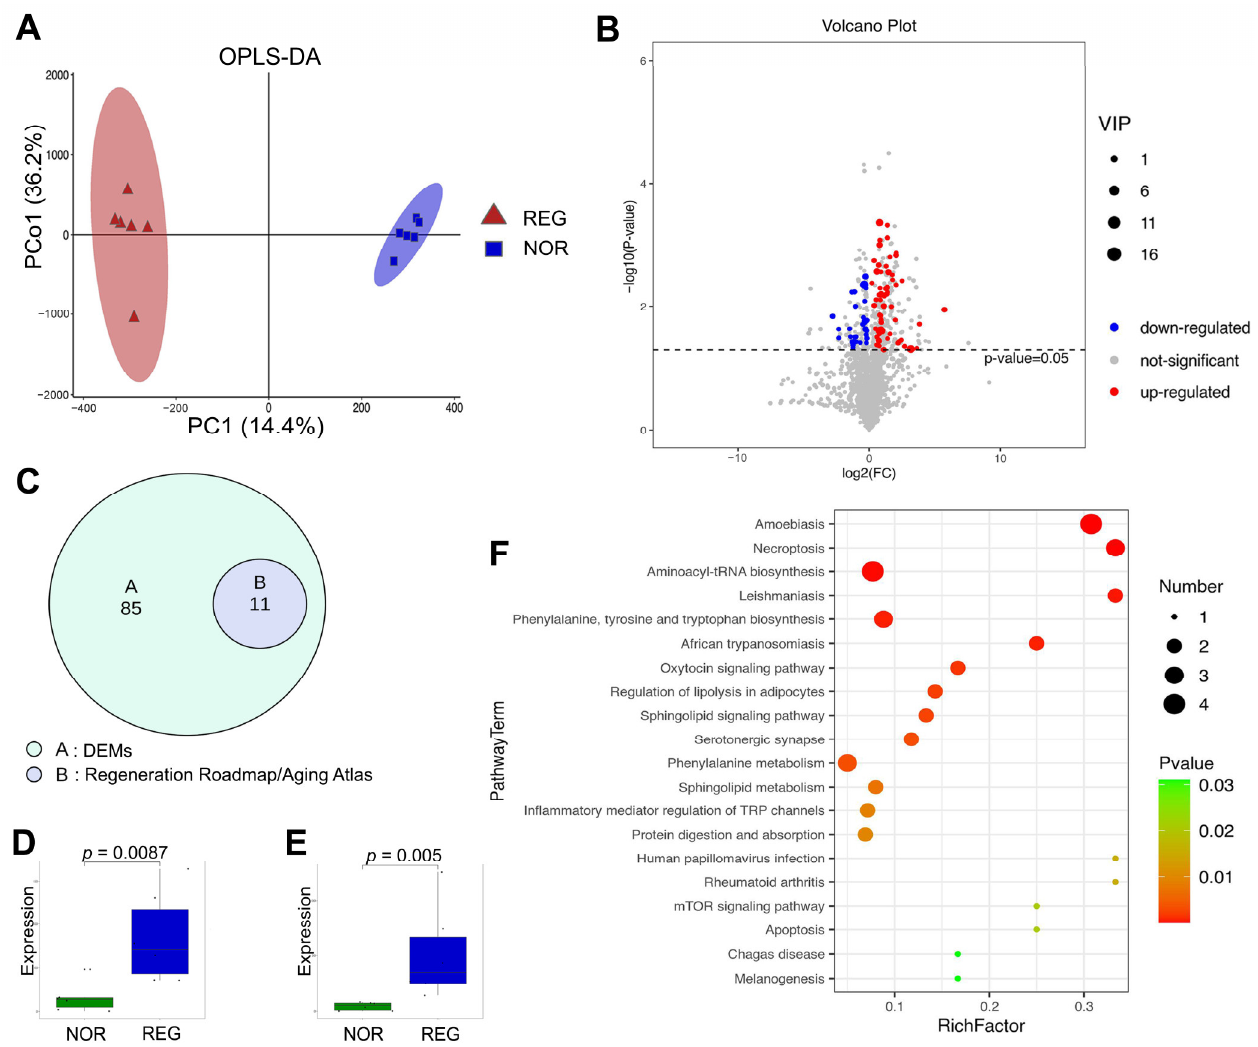
Figure 2. The global metabolomic profiles of the normal and regenerated cartilages. ( A ) The super- vised orthogonal partial least squares discriminant analysis (OPLS-DA) model reveals the metabolic differences between the NOR and REG groups. ( B ) The volcano plot indicates the upregulated differential metabolites (DEMs) in the REG group (red), the downregulated DEMs (blue), and non- significantly altered metabolites (gray). ( C ) Venn diagram shows the DEMs matched with the records in the Regeneration Roadmap and Aging Atlas databases. ( D , E ) The different expression levels of docosapentaenoic acid 22n-3 (DPA, ( D )) and ursodeoxycholic acid (UDCA, ( E )) between the NOR and REG groups are revealed. ( F ) The bubble diagram shows the top 20 differential metabolic path- ways enriched by the DEMs. X -axis represents rich factors, and Y -axis represents pathway terms. The numbers of the involved metabolites and p -value are listed on the right side. The detailed in- formation is presented in Supplementary Tables S1 and S2.